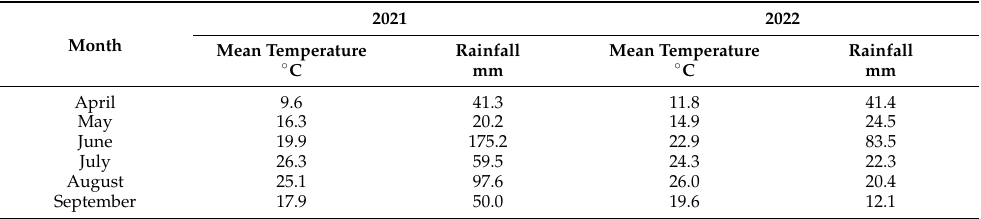
Table 7. Mean temperature and total rainfall during the